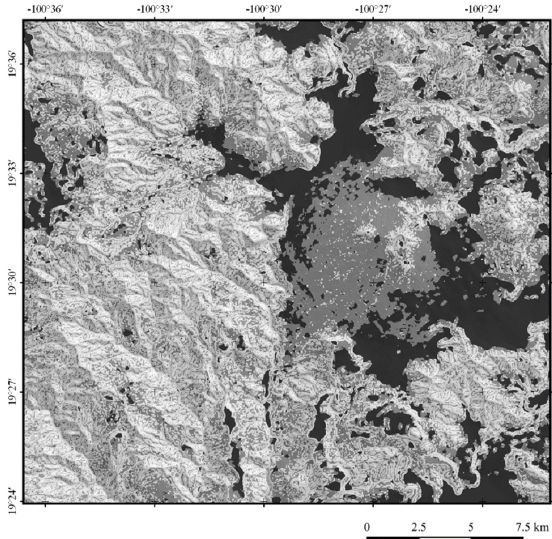
Figure 14 . Light grey: Low roughness regions with a slope greater than 4°: dark grey: Low roughness regions with a slope lower than